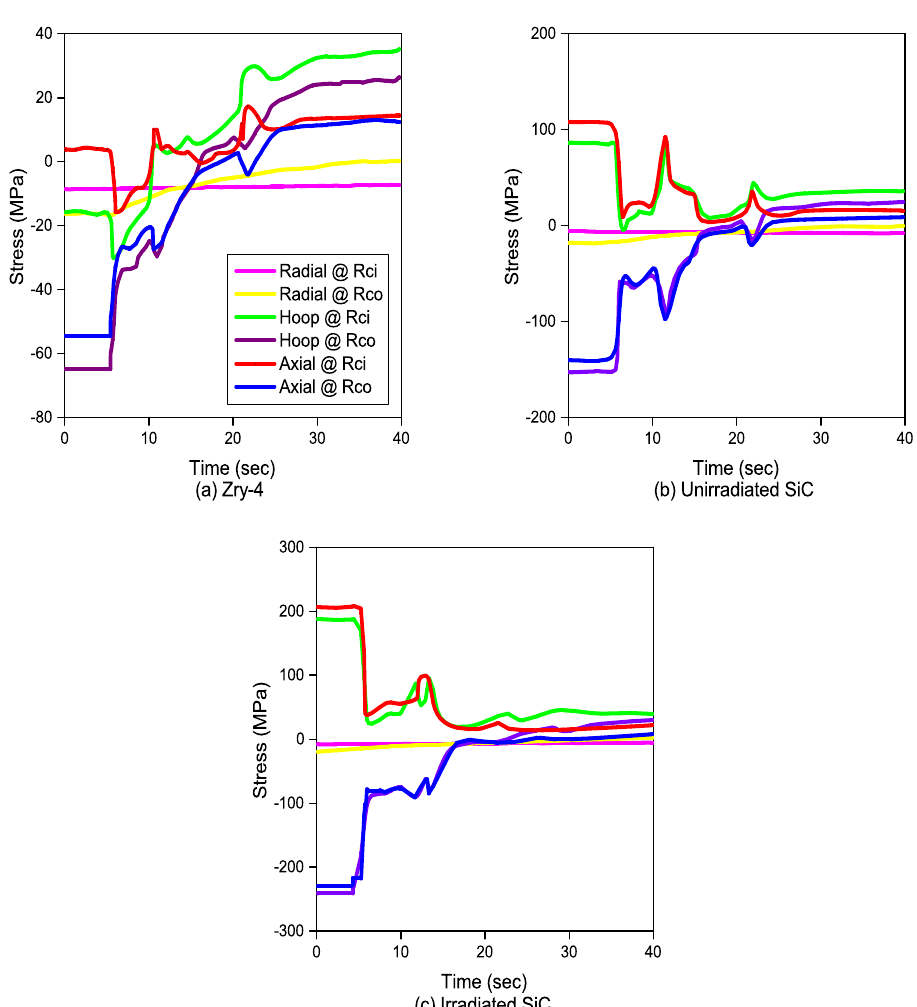
Figure 8. Secondary stress